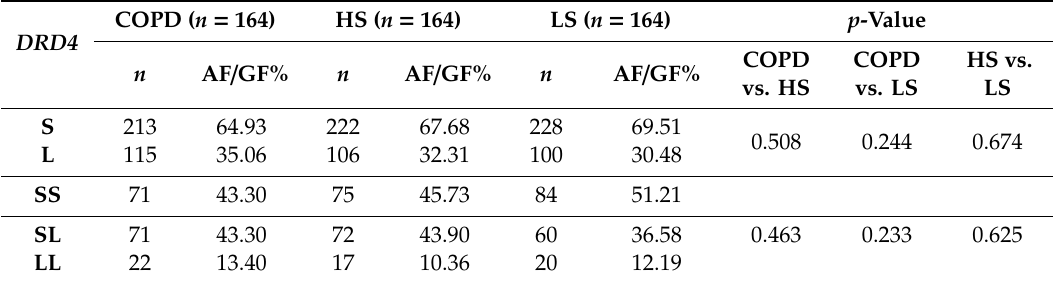
Table 2. Allele and genotype frequencies of VNTR in DRD4 among study groups.